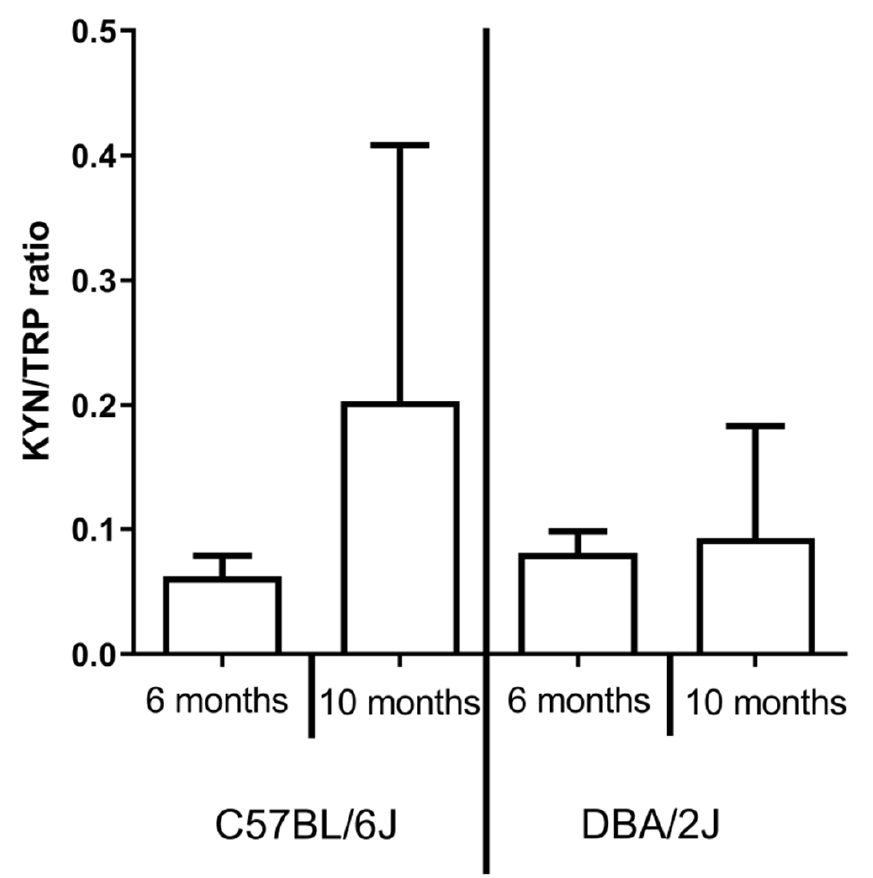
Figure 4. Indoleamine 2,3 dioxygenase (IDO) activity was expressed as a kynurenine/tryptophan ratio in the retina of C57BL/6 and DBA/2J mice.